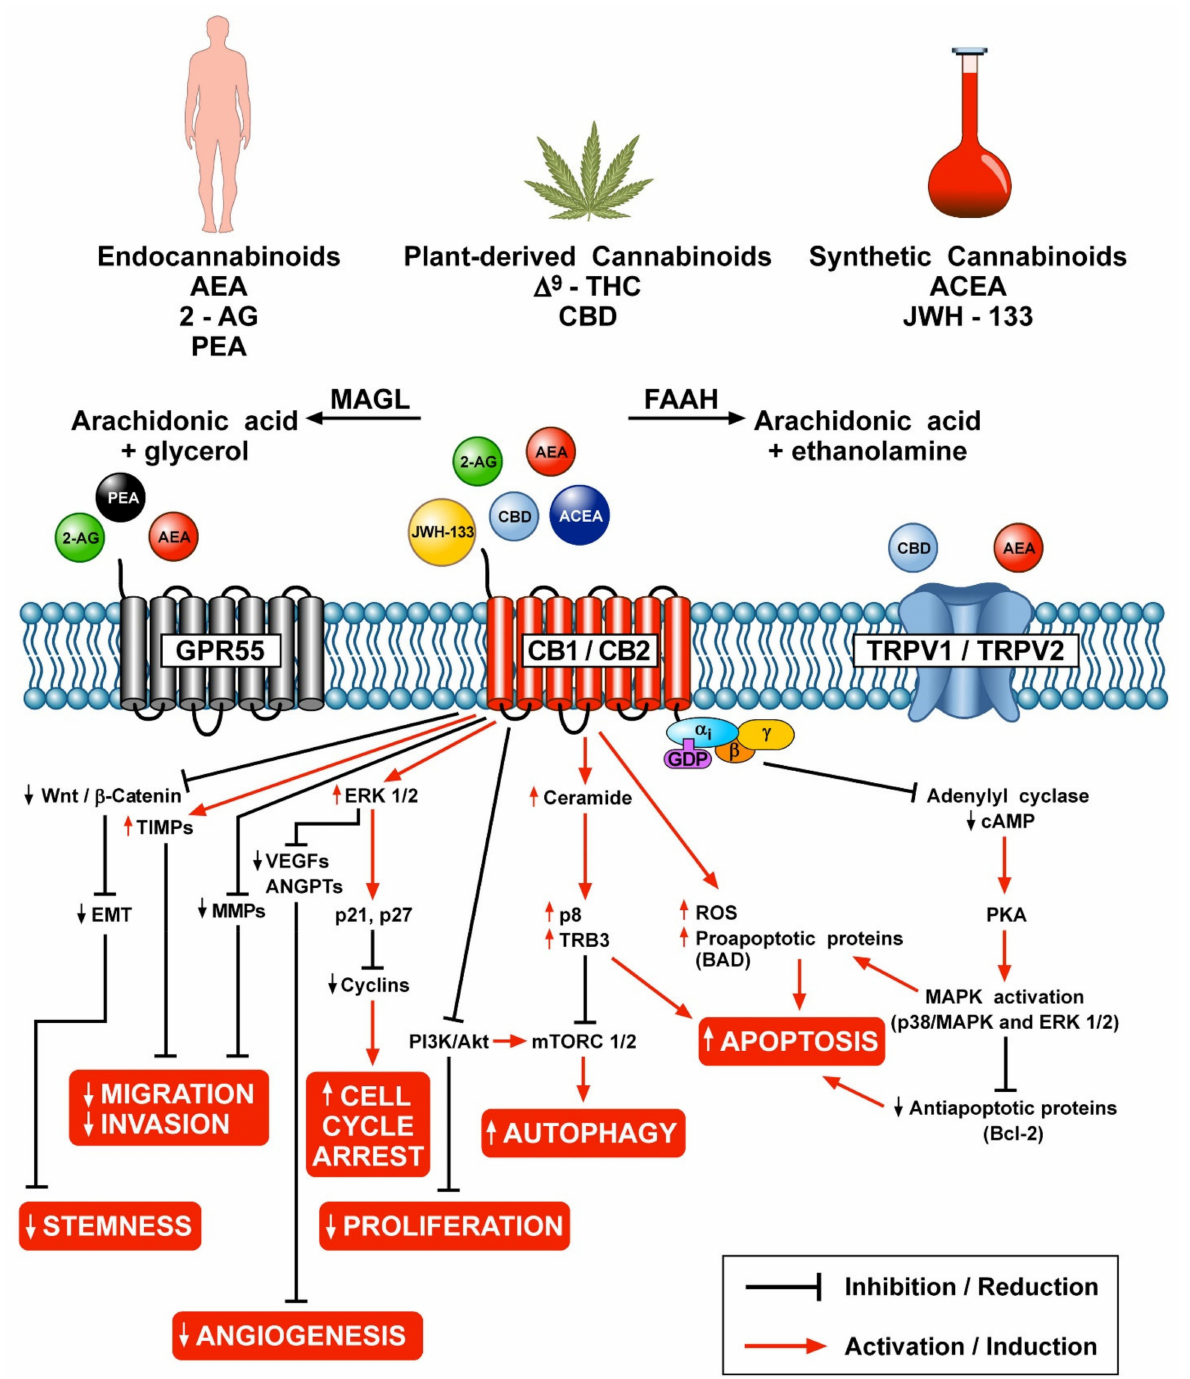
Figure 1. Schematic representation of the potential anticancer effects of endocannabinoids, phytocannabinoids and synthetic cannabinoids through the activation of CB1/CB2, GPR55 and TRPV1/TRPV2